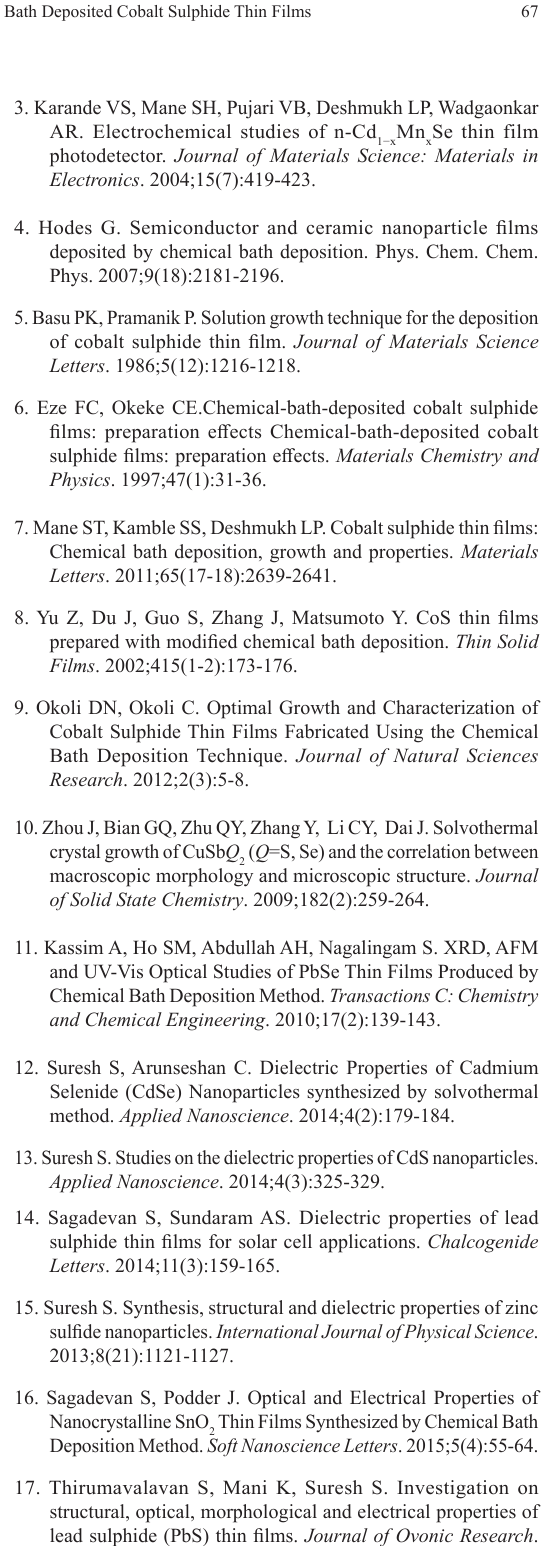
Figure 9: Plot of lnσ